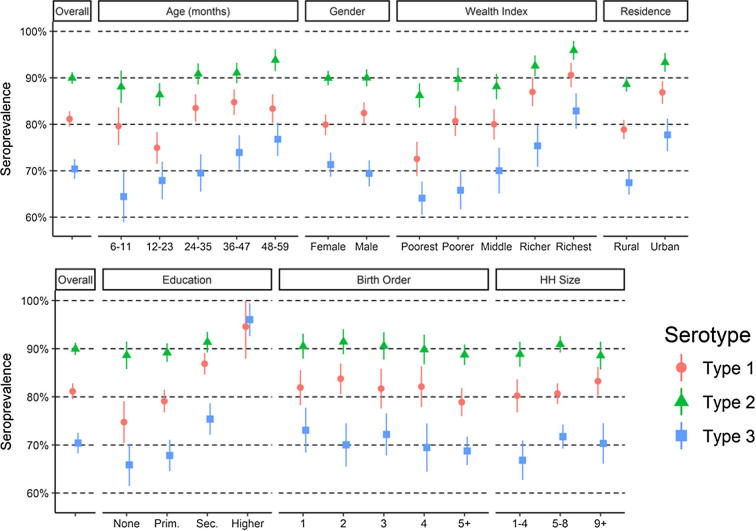
Seroprevalence by demographic characteristics.